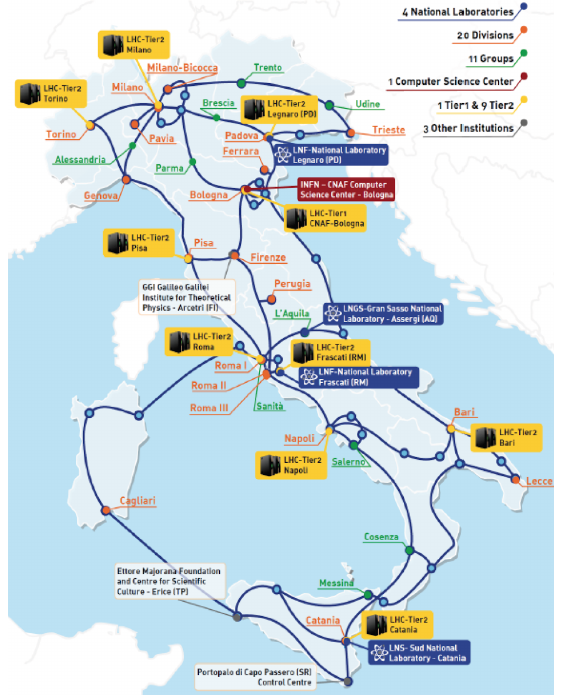
Figure 1. Datacenter collaboration network in ​